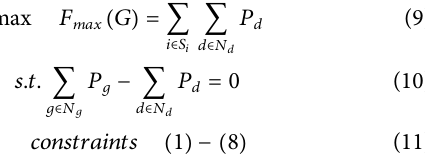
Frontiers in Physics |